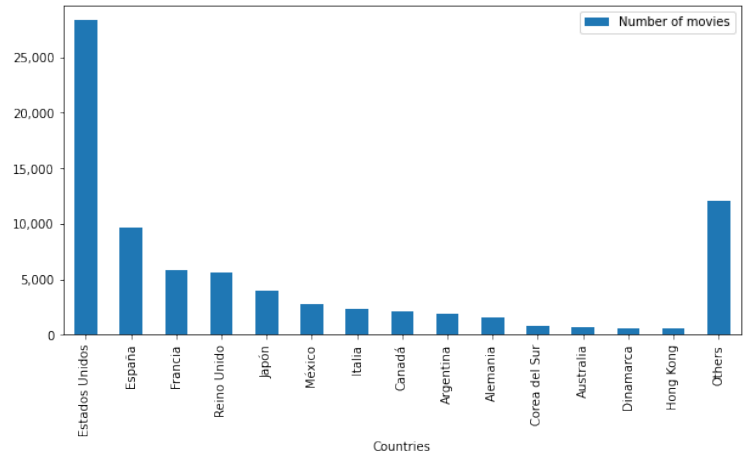
Figure 1. Movie country distribution. Following, in Figure 2, the distribution of the movie’s duration is shown.